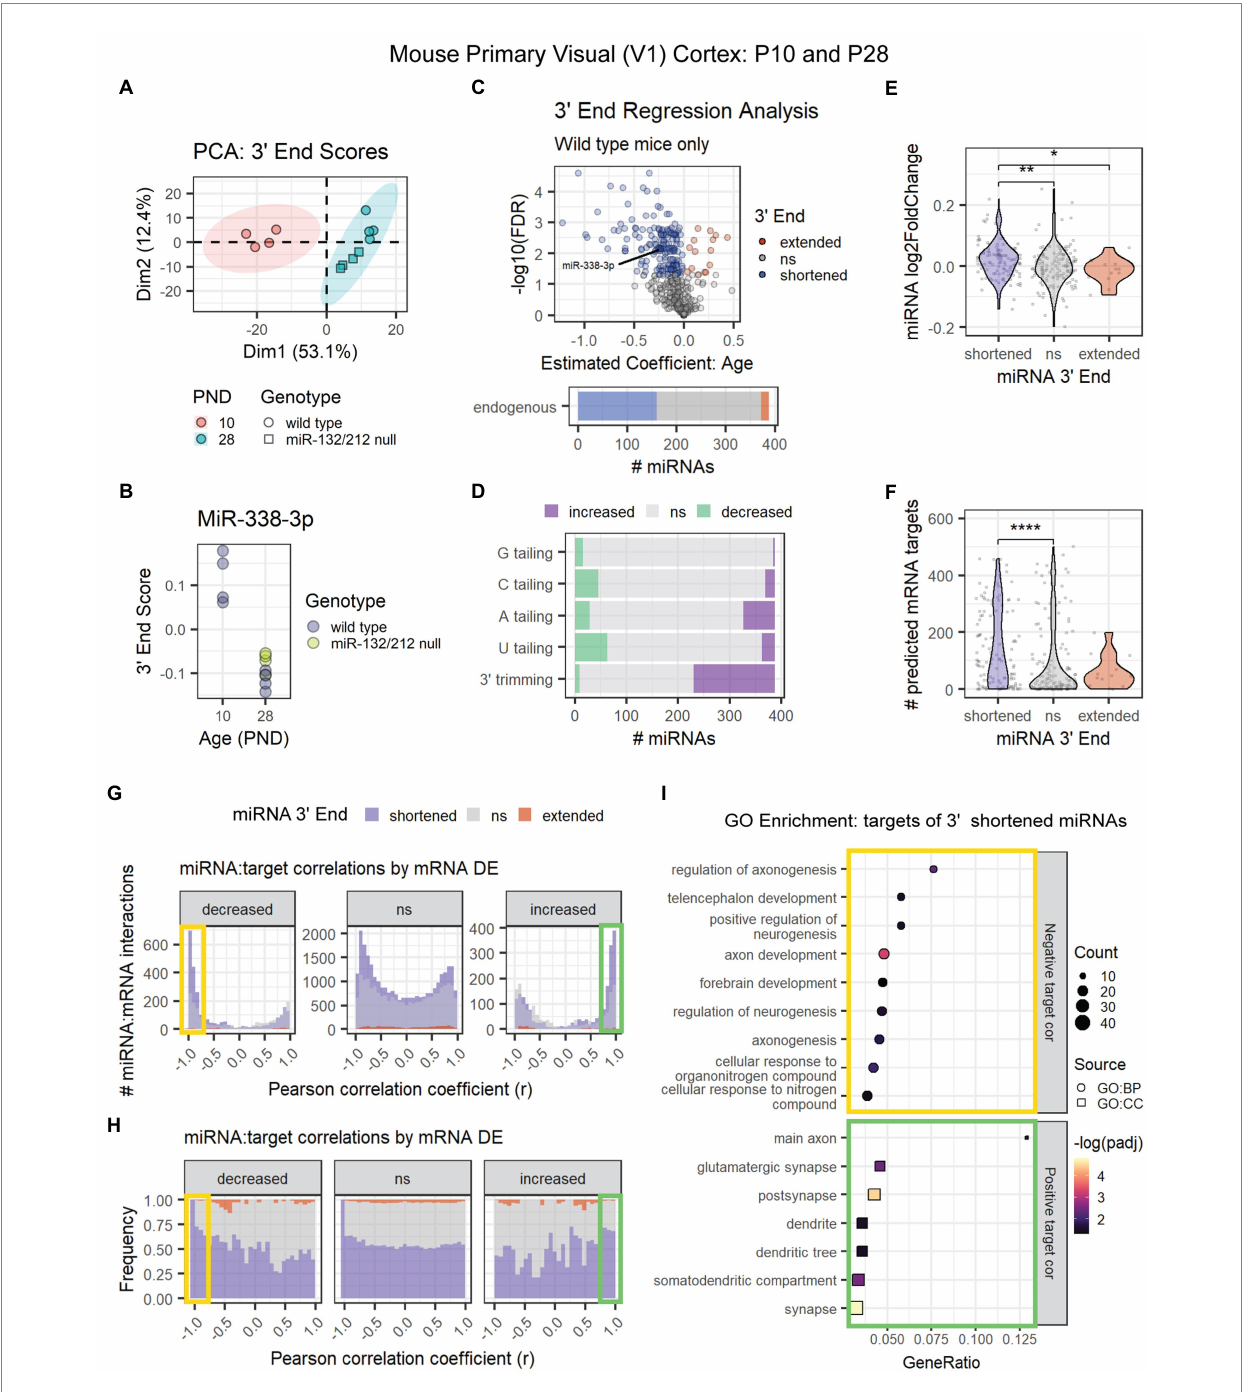
FIGURE 5 Age-associated 3 ′ shortening of miRNAs occurs in mouse V1 cortex between P10 and P28. (A) PCA was performed on 3 ′ end scores derived from miRNA-seq data from P10 and P28 mouse V1 cortex. Samples clustered by age. No outliers were identified. (B) MiR-338-3p 3 ′ end scores decrease between P10 and P28. (C) 3 ′ ERA results demonstrate that ~40% of miRNAs exhibit increased 3 ′ shortening. (D) 3 ′ ERA results were subset by 3 ′ modification type. 3 ′ shortening is primarily the result of increased 3 ′ trimming with age. (E) Violin plot representing the relationship between miRNA 3 ′ end dynamics with age and the miRNA’s log 2 fold change between P10 and P28. Each point represents one miRNA. Kruskal-Wallis: p = 0.0058. Wilcox test for pairwise comparisons: * p < 0.05, ** p < 0.01. (F) Violin plot representing the relationship between miRNA 3 ′ end dynamics with age and the number of predicted targets detected in mRNA-seq data. Each point represents one miRNA. Kruskal-Wallis: p = 0.00018. Wilcox test for pairwise comparisons: **** p < 0.0001. (G) Pearson correlation analysis was performed for miRNAs and their predicted mRNA targets. Data are organized in histograms by mRNA DE cluster. Y -axis reflects the number of predicted miRNA:target interaction pairs at each Pearson correlation coefficient, r, value. Bar color reflects each miRNA’s 3 ′ end dynamics with age. (H) Pearson correlation analysis organized by mRNA DE results. Y -axis indicates the relative frequency of targeting by miRNAs that have shortened, extended, or stable (ns) 3 ′ ends with age. Bar color reflects miRNA 3 ′ end dynamics with age. (I) GO term enrichment analysis results for mRNA targets that decreased with age and exhibited negative correlations ( r < − 0.75, orange box in G,H ) or increased with age and exhibited positive correlations ( r > 0.75, green box in G,H ) with miRNAs that underwent 3 ′